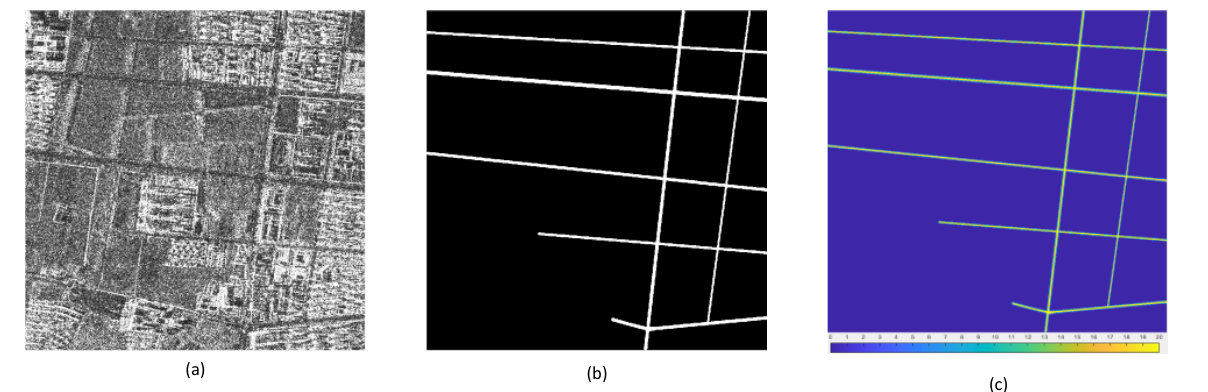
Figure 3. ( a ): SAR image. ( b ): ground truth of road. ( c ): ground truth of discrete label. Algorithm 1 Obtain Road Centerline and Road Width Ground Truth